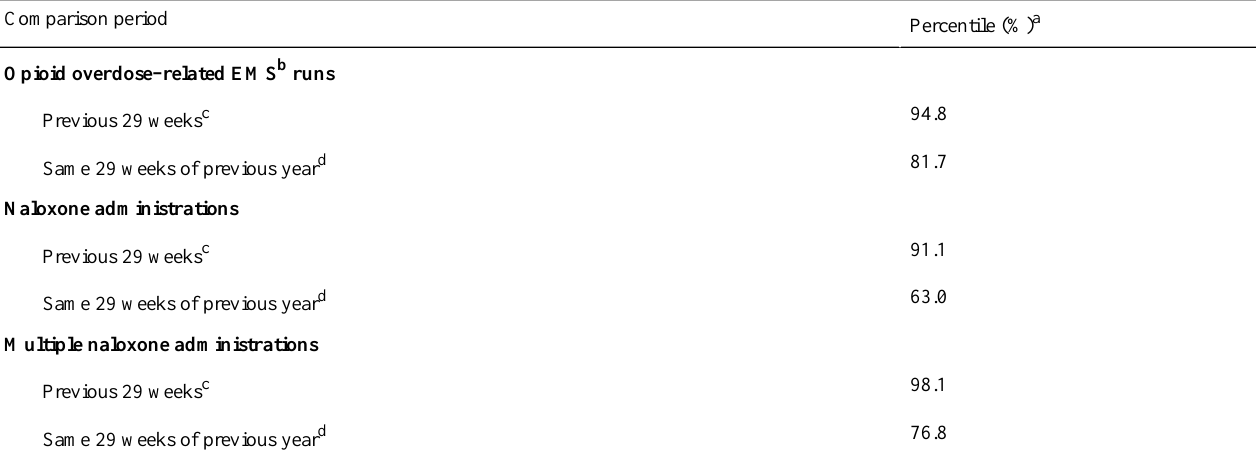
Table 2. Magnitude of period-over-period change in EMS runs involving opioid overdoses, naloxone administrations, and multiple naloxone administrations in Guilford County, North Carolina before the COVID-19 state of emergency declaration.